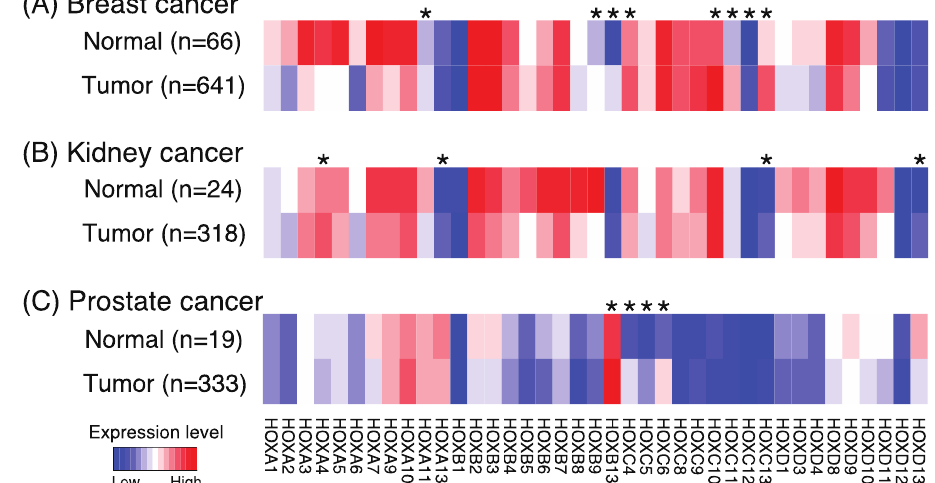
Figure 3. Expression of the 39 human HOX genes in normal vs tumor samples. Shown are heatmaps indicating relative expression levels of the human HOX genes in normal and tumor samples from breast ( A ), kidney ( B ), and prostate ( C ) TCGA RNA-seq datasets. RNA-seq data were normalized as previously described [23]. Wilcoxon rank sum tests were performed between normal and tumor groups, and p values were adjusted using the Holm method. An asterisk indicates genes showing a significant upregulation in the tumor samples as compared to the normal samples (adjusted p value <0.01).